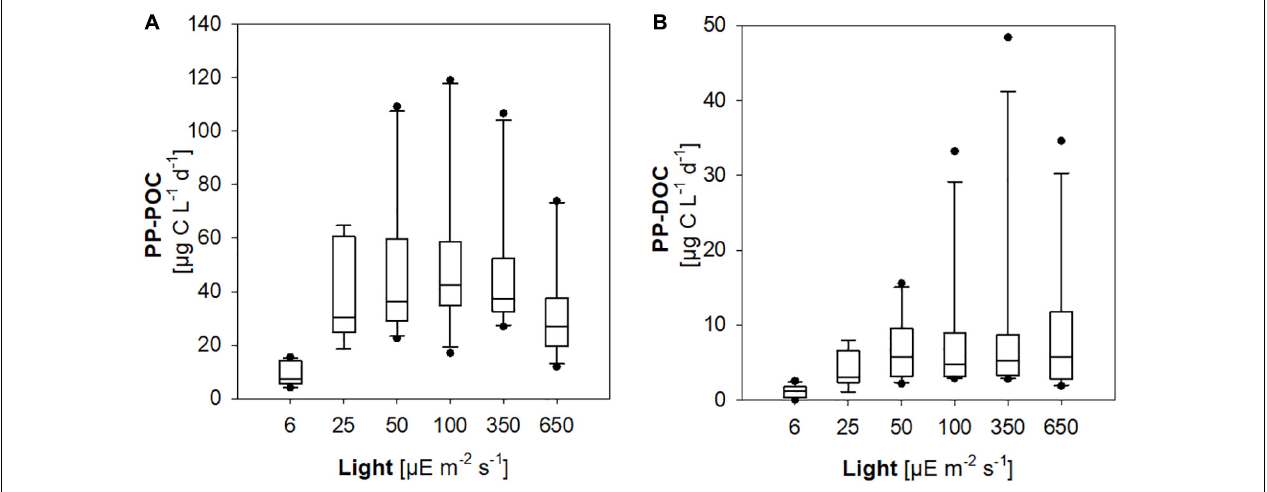
FIGURE 4 | Primary production of phytoplankton communities at different experimental light levels. (A) Particulate primary production (PP-POC). (B) Dissolved primary production (PP-DOC).